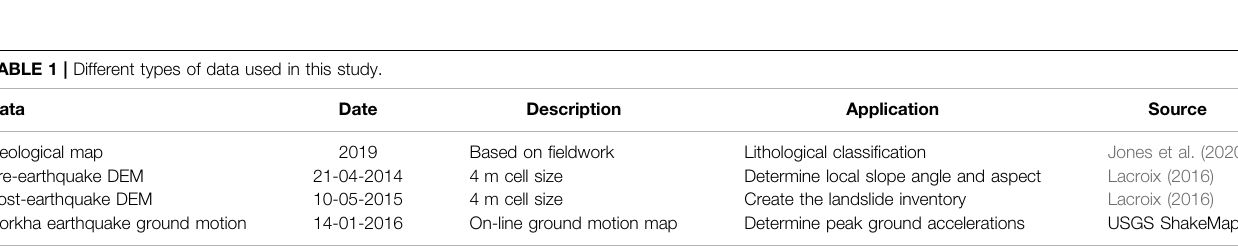
TABLE 1 | Different types of data used in this